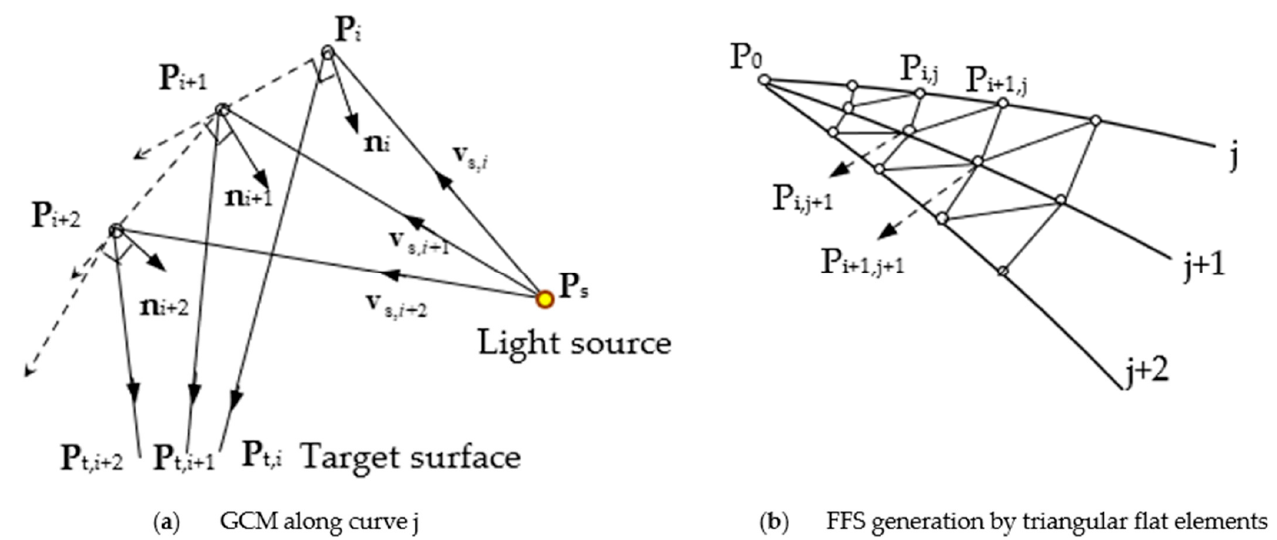
Figure 5. Generation and joining of discrete points on FFS.